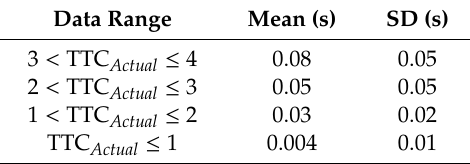
Table 9. Errors in the estimated TTC for the vehicle–vehicle collision scenario.